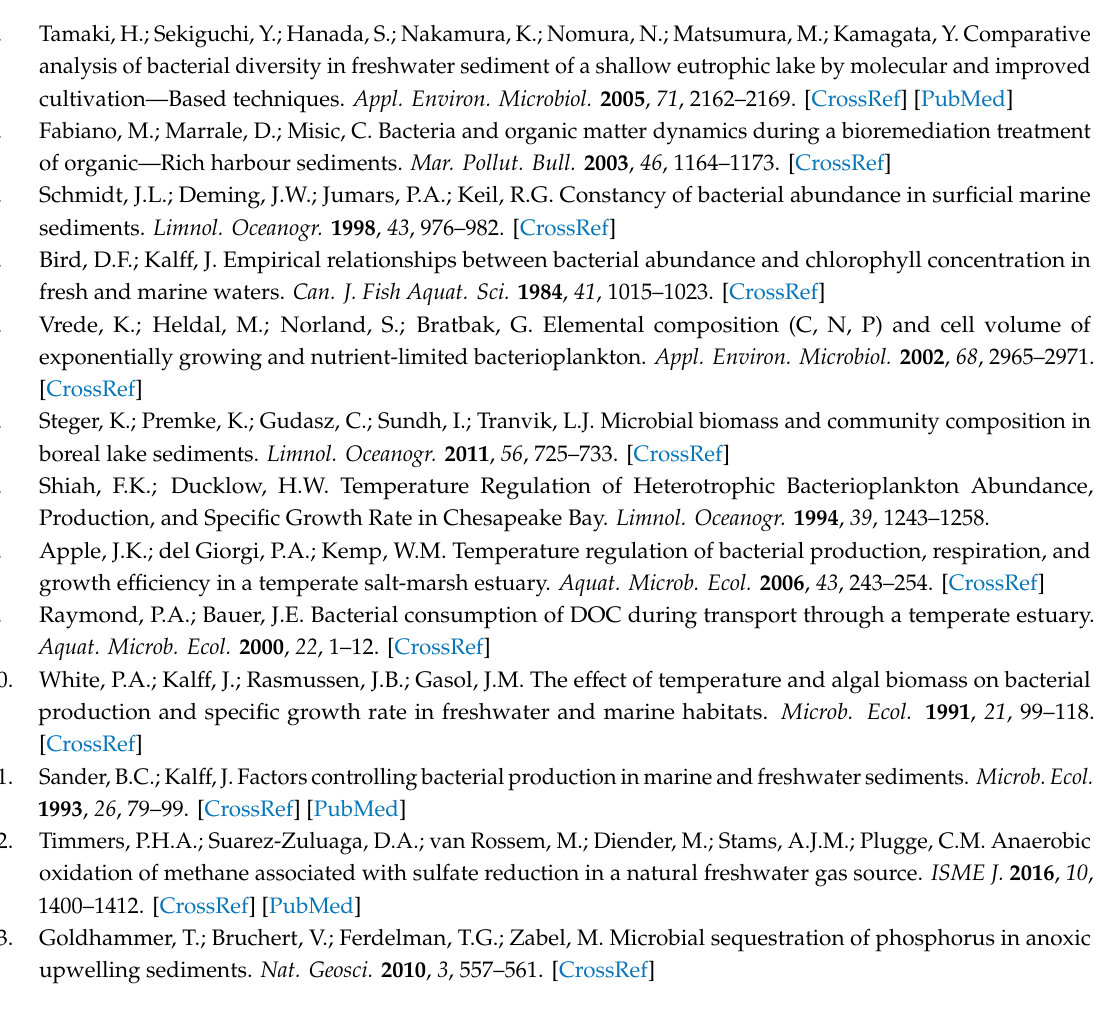
Table S1: Physical and chemical characteristics and ANOVA (F and p ) at di ff erent depths in Gongguoqiao